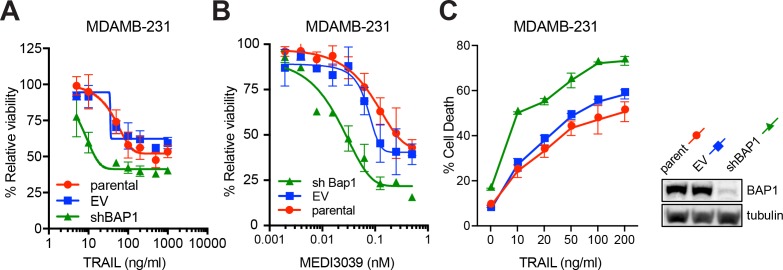
shRNA knockdown of BAP1 increases sensitivity to DR agonists in breast cancer cells. The MDAMB-231 breast cancer cell line was transduced with empty vector (EV) or BAP1 shRNA (shBAP1). Immunoblot confirmed BAP1 knockdown. Cells were treated with (A) rTRAIL and (B) MEDI3039 and cell viability measured with MTT assay at 72 hr. (C) Cells were treated with rTRAIL for 24 hr and cell death measured with Annexin V/DAPI flow cytometry assay.